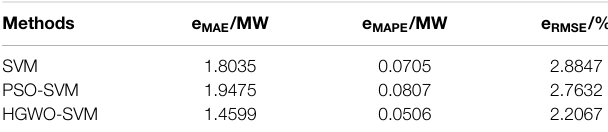
TABLE 3 | Comparison of multi-method PV output prediction